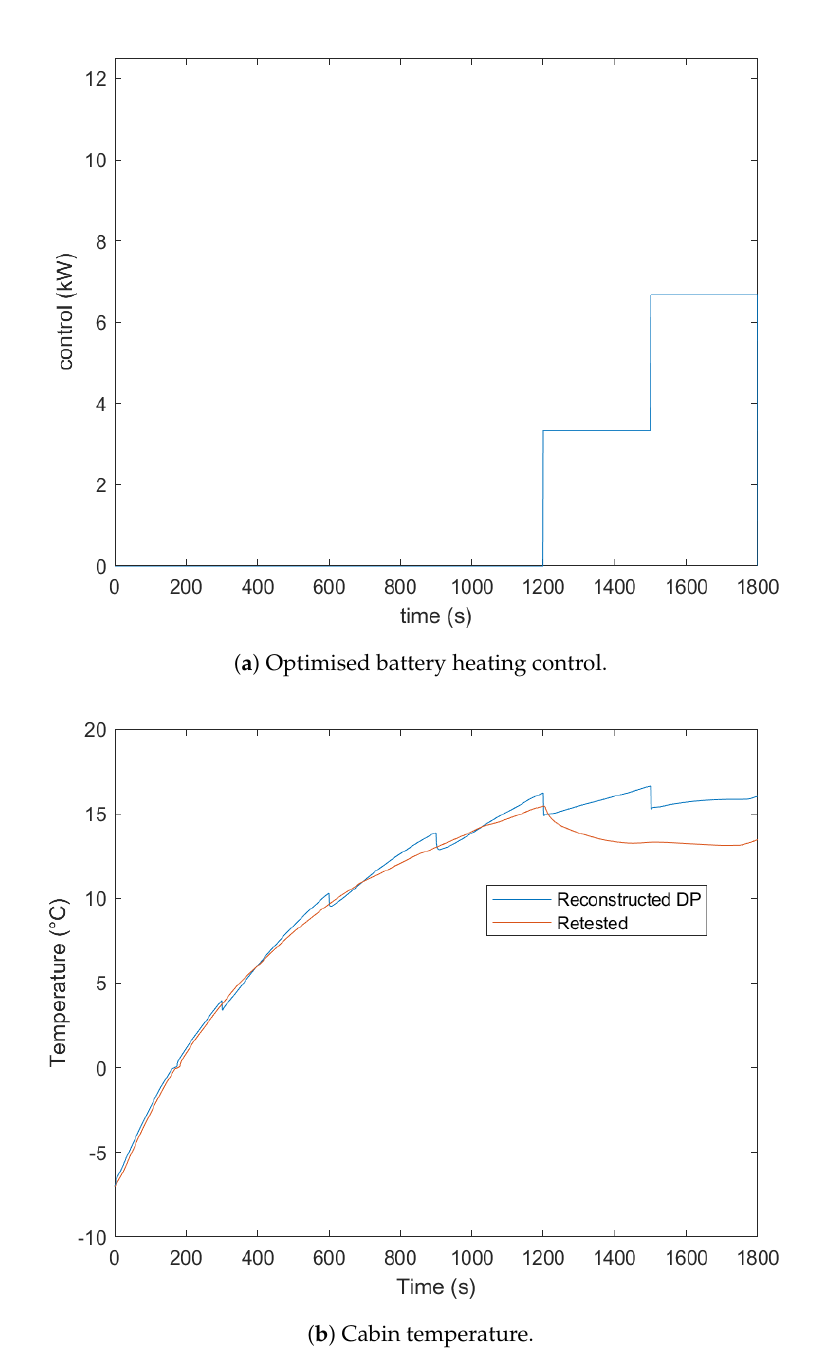
Figure 19. Battery heating control and cabin temperature resulting from optimisation using “Cabin N”